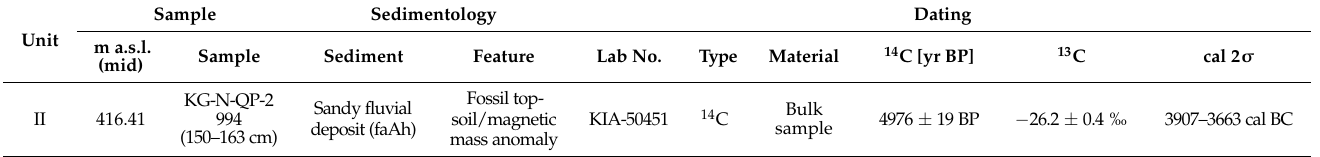
Table 1. Stratigraphy position and dating of the fossil topsoil below the magnetic mass anomaly by radiocarbon dating. Sample Unit